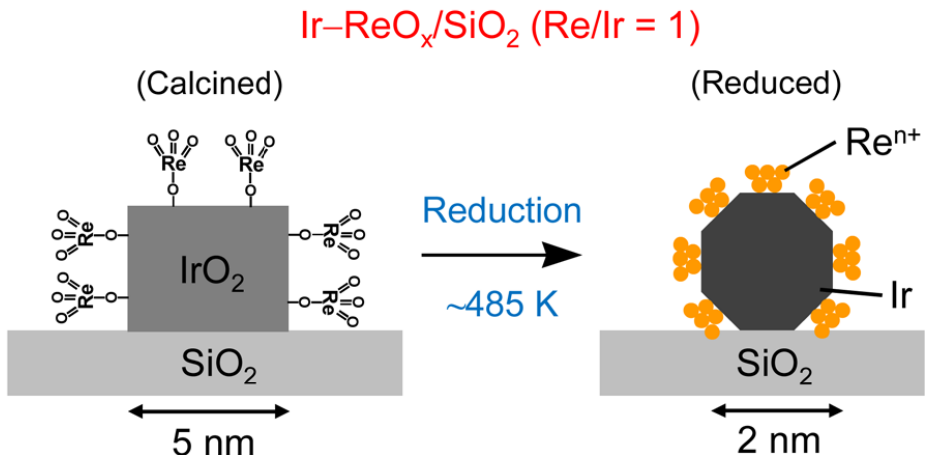
Figure 9. The formation of metallic Ir particles covered by Re oxides. Reproduced from [87] with permission from American Chemical Society (ACS).